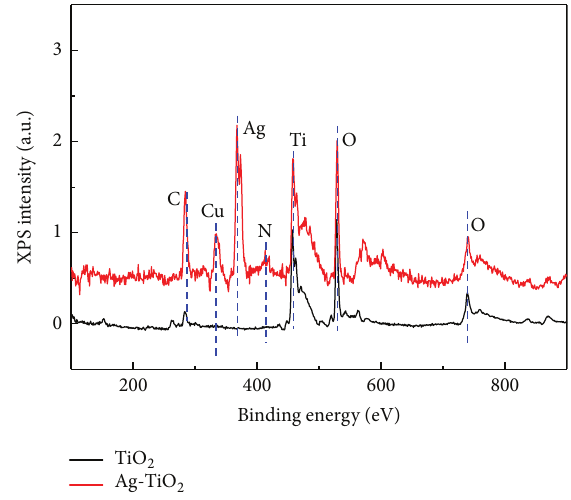
Figure 2: XPS survey recorded for titania and Ag-doped titania.